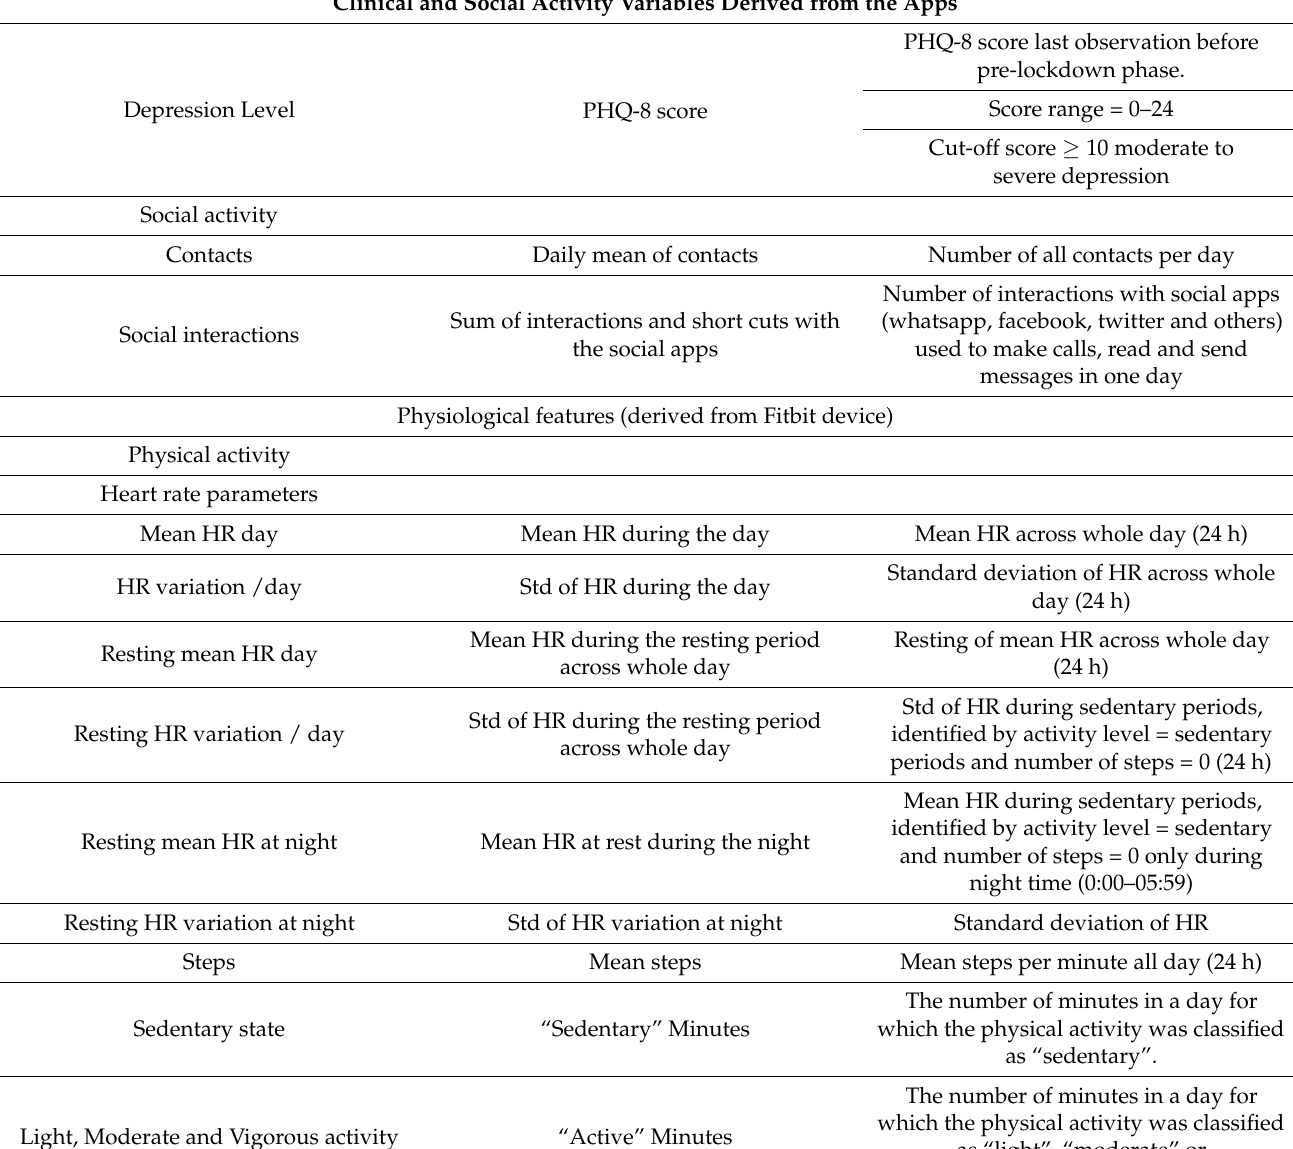
Table 1. Variables assessed in the study. Clinical and Social Activity Variables Derived from the